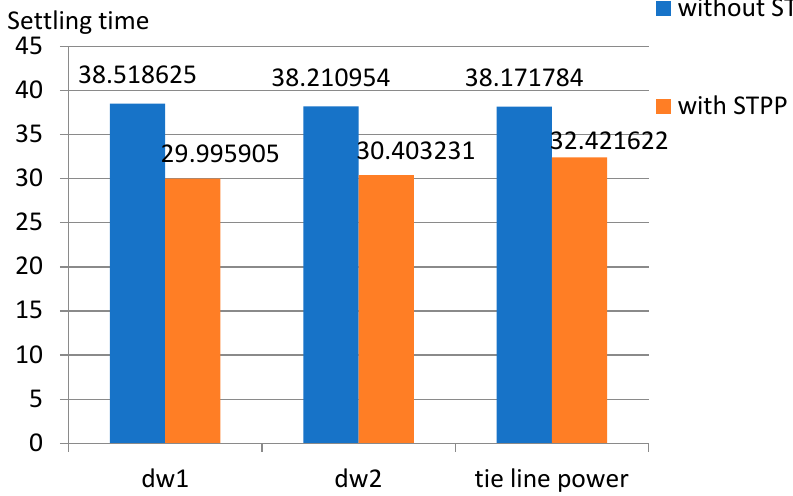
Figure 17. Variations of settling time with step load perturbation.